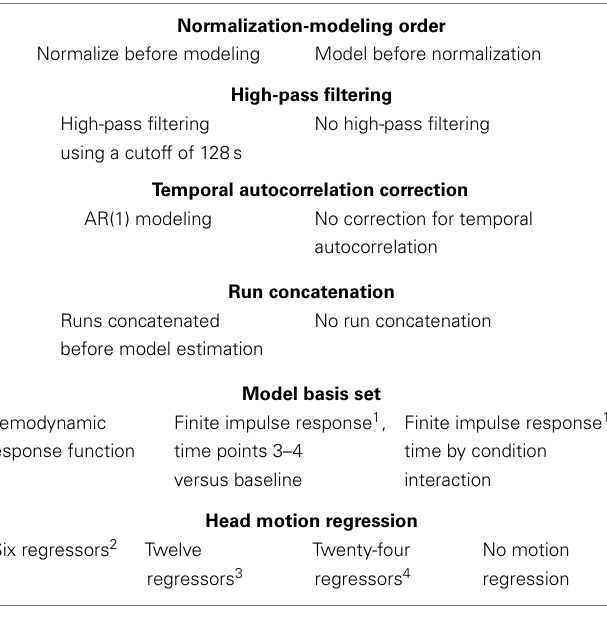
Table 1 | Pre-processing parameters. Table 2 | Model estimation